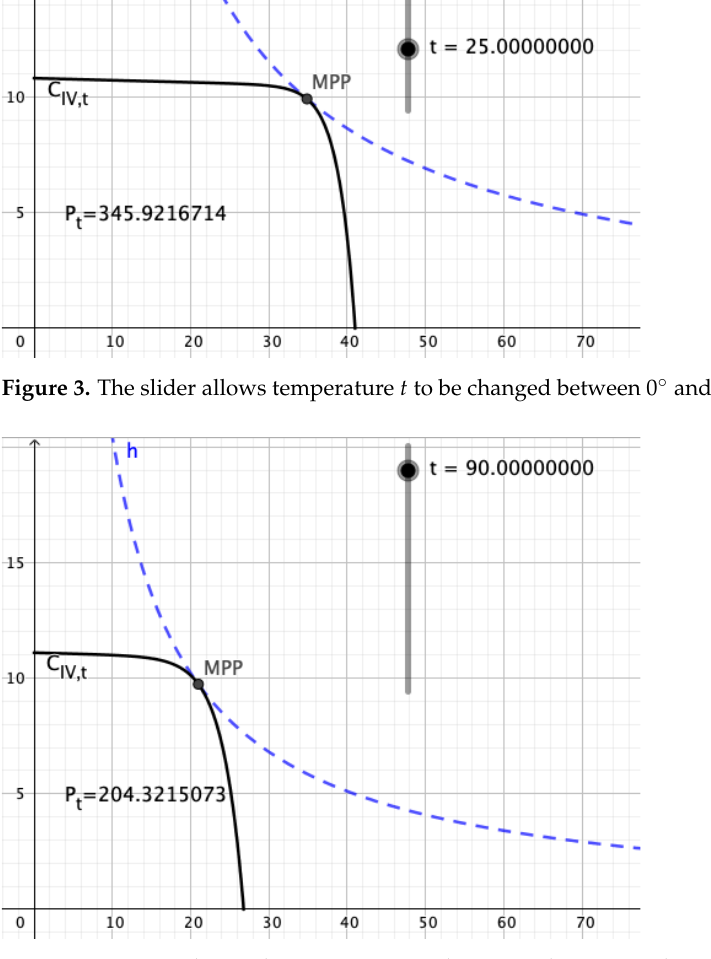
Figure 4. One can observe how curve C IV and its MPP change; number P t denotes the power at